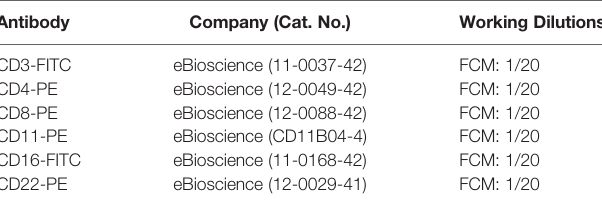
TABLE 3 | Primary antibodies used for Flow cytometry. Antibody Company (Cat. No.) Working